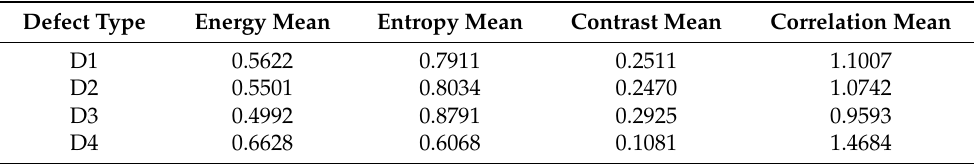
Table 5. Texture feature information of selected defect image.